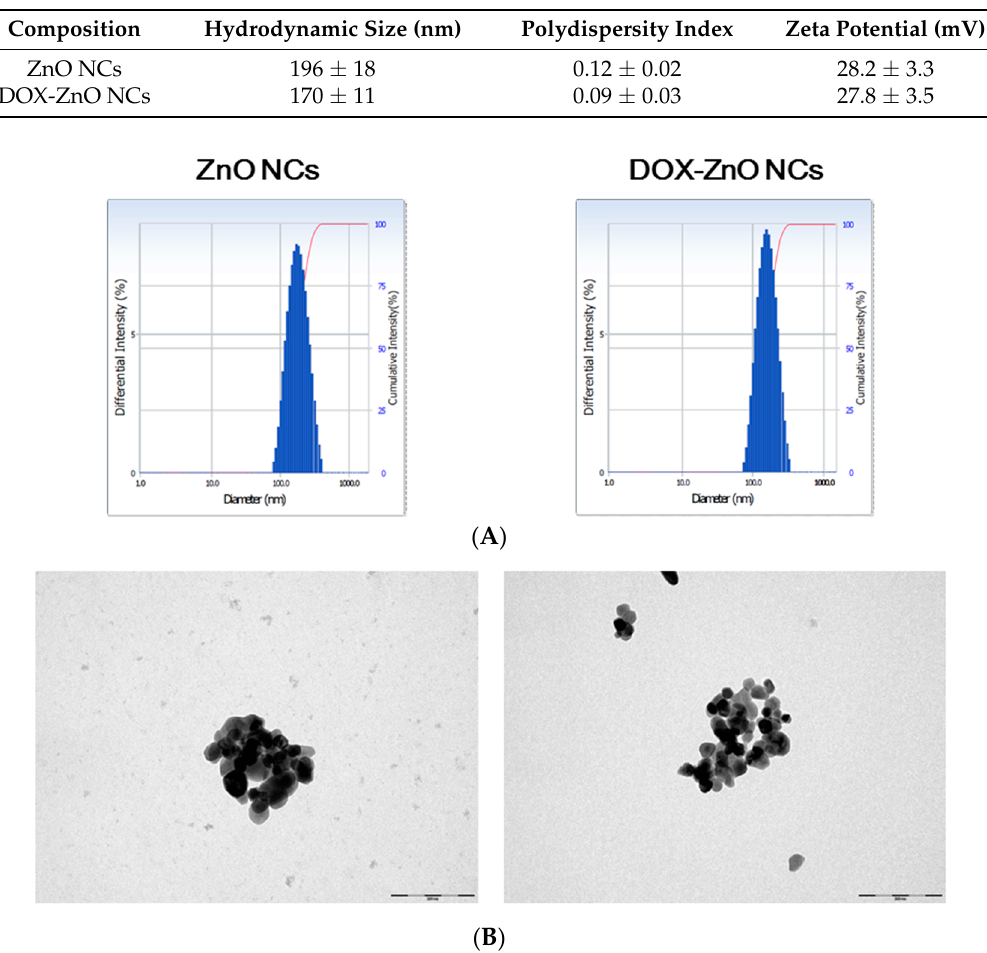
Figure 2. Particle characterizations of developed NCs. ( A ) Size distribution of dispersion of ZnO NCs and DOX-ZnO NCs. Differential intensity value according to the mean diameter of each formulation is plotted; ( B ) TEM image of dispersion of ZnO NCs and DOX-ZnO NCs. The length of the scale bar is 200 nm. Table 1. Particle characterizations of NCs ( n = 3).